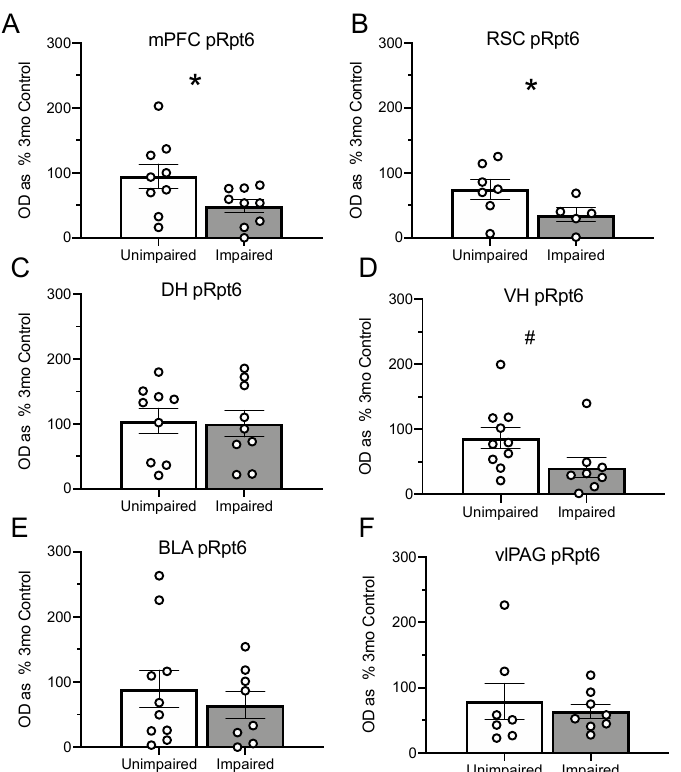
Figure 5. Animals were divided into two groups based on a median split of performance in the Post-CS period during the retrieval test. High freezers were designated as unimpaired, whereas low freezers were designated as impaired. Panels ( A – F ) show pRpt6 reported as a percentage (mean, SEM) in 3-month-old animals. Impaired animals showed less pRpt6 than unimpaired in both the mPFC ( A ) and the RSC ( B ). As before, there were no di ff erences in the DH ( C ). Impaired memory performance corresponded with a trend toward a decrease in the VH ( D ). No di ff erences between unimpaired and impaired animals were observed in the LA ( E ) or the vlPAG ( F ). Asterisks indicate p < 0.05; pound signs indicate p < 0.10. White dots represent individual rats.